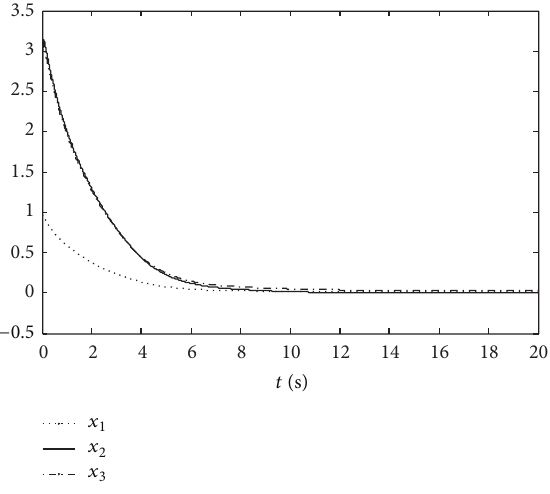
Figure 5: System responses under the control of the proposed FTC ((30a), (30b), (30c), (30d), and